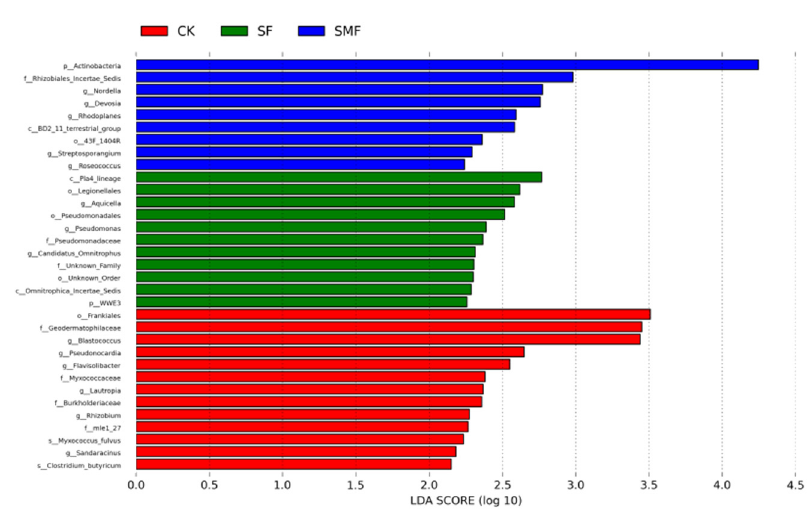
Figure 5. LDA obtained from LEfSe analysis showing changes in dominant bacterial communities at different taxonomic levels among different treatments.